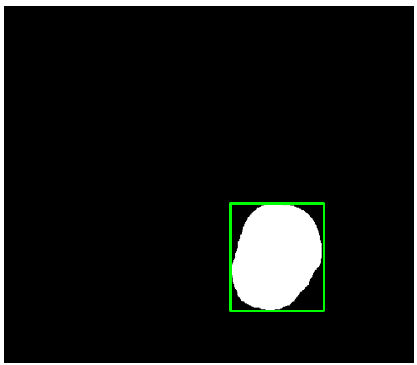
Figure 5. Segmented polyp image.